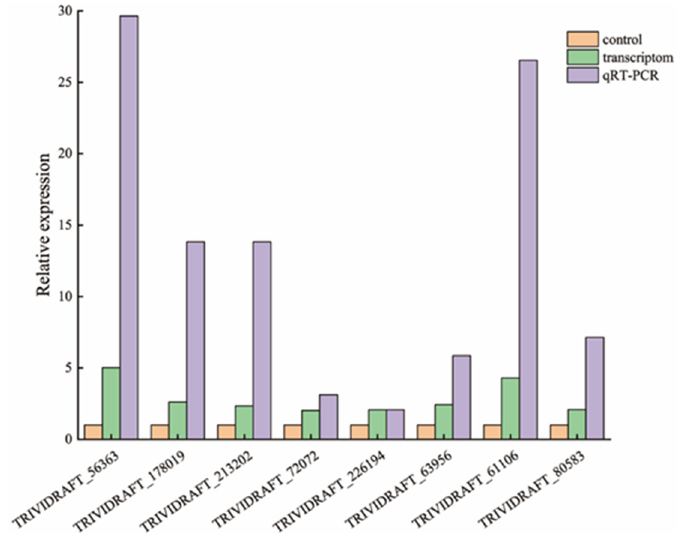
Figure 9. qRT-PCR quantitative analysis.